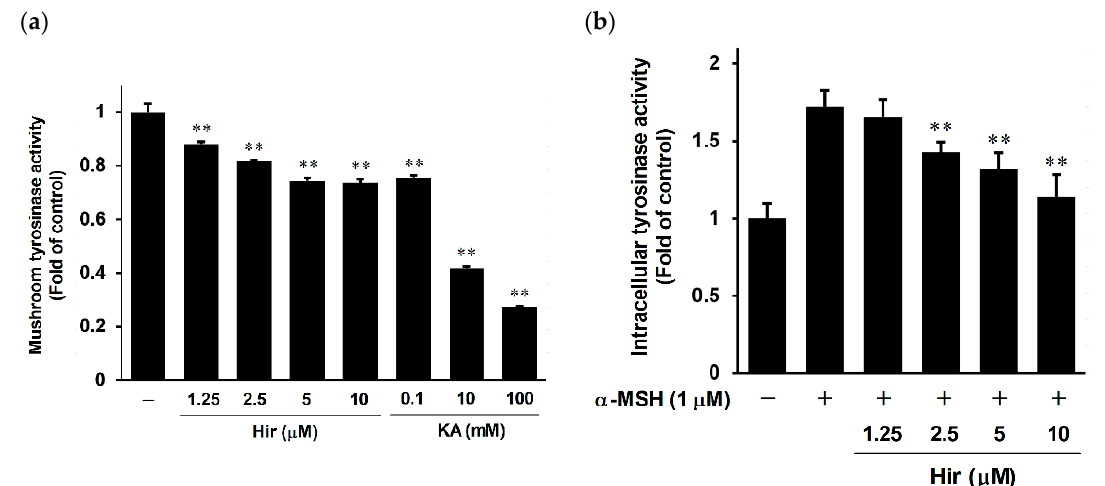
Figure 4. Effect of Hir on tyrosinase activity. ( a ) Mushroom tyrosinase activity was determined as described in Materials and Methods. Kojic acid (KA) was used as a positive control. Values are the mean ± SD of three independent experiments. ** p < 0.01 versus control. ( b ) B16-F1 cells were treated with Hir at the indicated concentrations for 72 h, and intracellular tyrosinase activity was determined as described in Materials and Methods. Values are the mean ± SD of three independent experiments. ** p < 0.01 versus α -MSH.